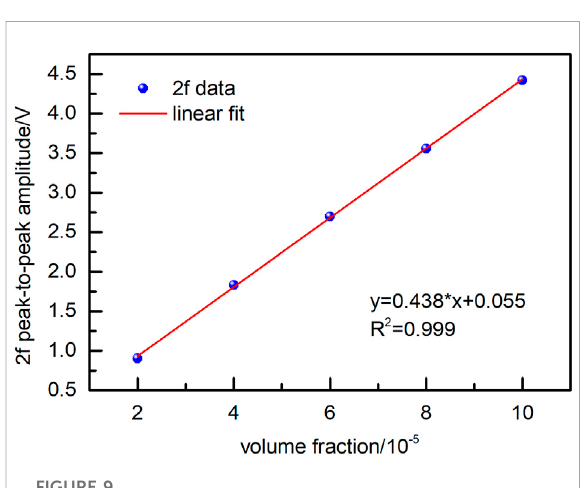
FIGURE 9 Relationship between 2f signal and volume fraction of